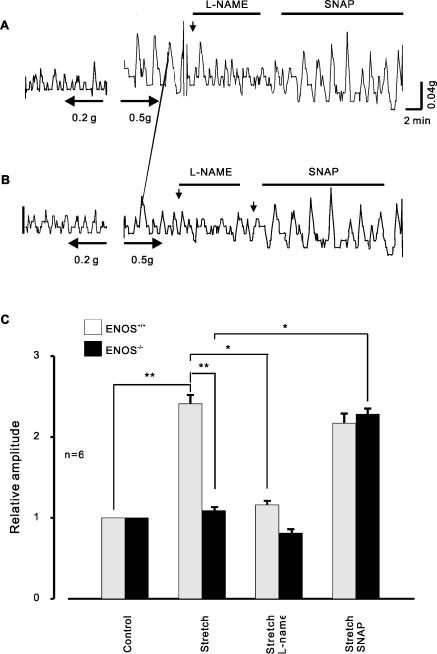
NO mediated contraction of mouse bladder smooth muscle strips.A&B, samples of spontaneous contractions recorded in wildtype (A) and eNOS deleted (B) mouse urinary bladder smooth muscle strips. After stretch to 0.5 g from the control (0.2 g), the amplitude of contraction was prominent increased in wildtype myocytes (n = 6, **p<0.01) but not in eNOS knockout myocytes; the stretch induced increase in amplitude of contraction could be inhibited by application of L-NAME (*P<0.05). In contrast to wildtype strip, eNOS deficient strip did not response to this compound but did response to SNAP (B, n = 6, *P<0.01). C, summary data of contraction amplitude. n = 6, *P<0.05, **P<0.01, respectively.